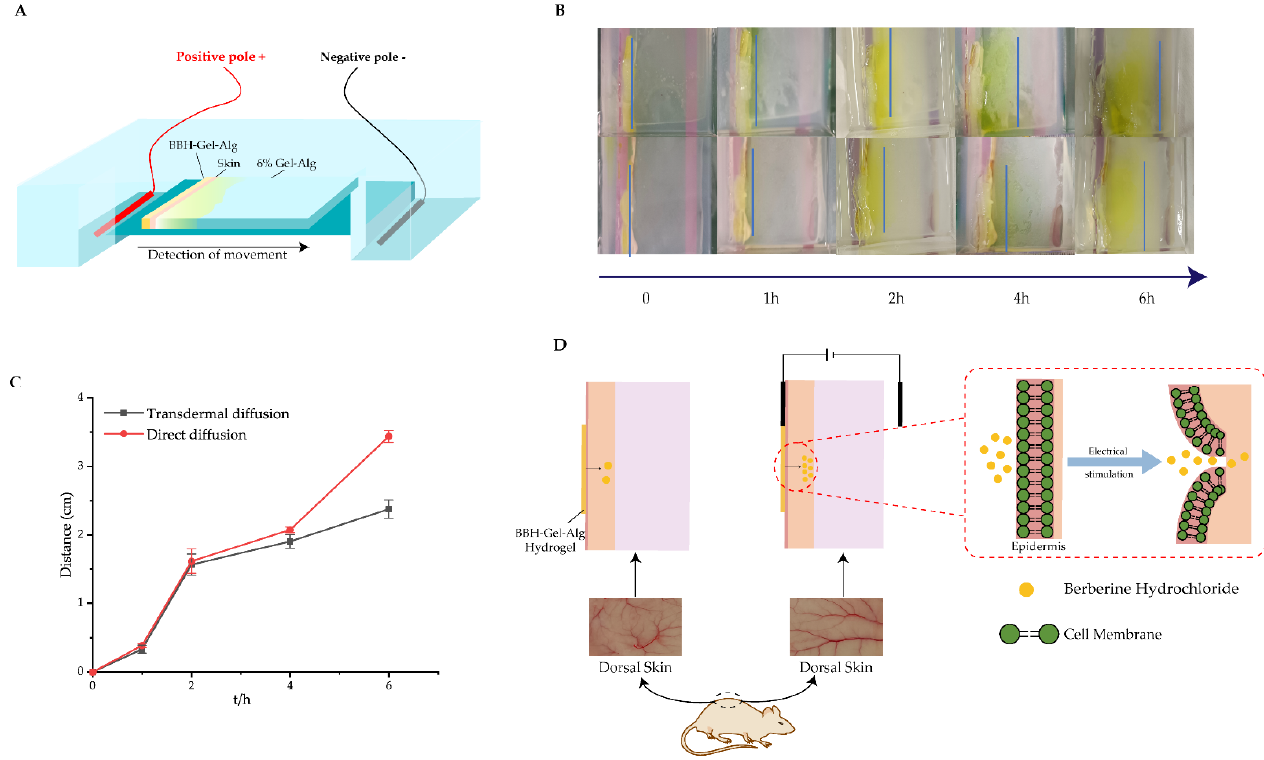
Figure 7. The results and schematic diagram of berberine hydrochloride migration across the skin tissue under electrical stimulation. ( A ) Schematic diagram of hydrogel electrophoresis apparatus; ( B ) The migration behavior (the distance) of BBH–Gel–Alg with times; ( C ) the moving distance of BBH–Gel–Alg with time under power on and power off conditions (Line chart); ( D ) Transdermal electroosmosis mechanism of BBH-loaded Gel–Alg hydrogel.